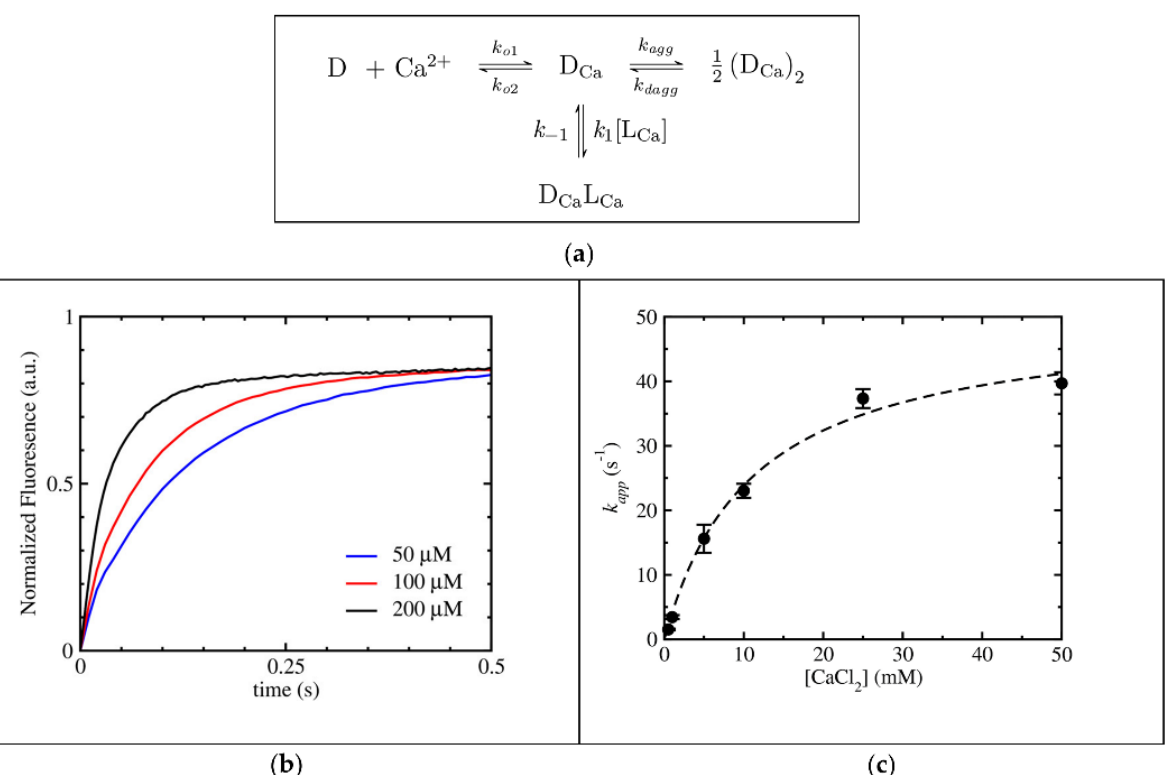
Figure 4. Kinetic analysis of the binding of daptomycin to lipid vesicles in the presence of calcium ions. ( a ) Kinetic model; ( b ) kinetics of daptomycin binding to lipid vesicles as a function of the lipid concentration; ( c ) apparent rate constant of binding, k app , dependence on the calcium ion concentration. Figure adapted with permission from reference [71]. Copyright 2018 American Chemical Society.